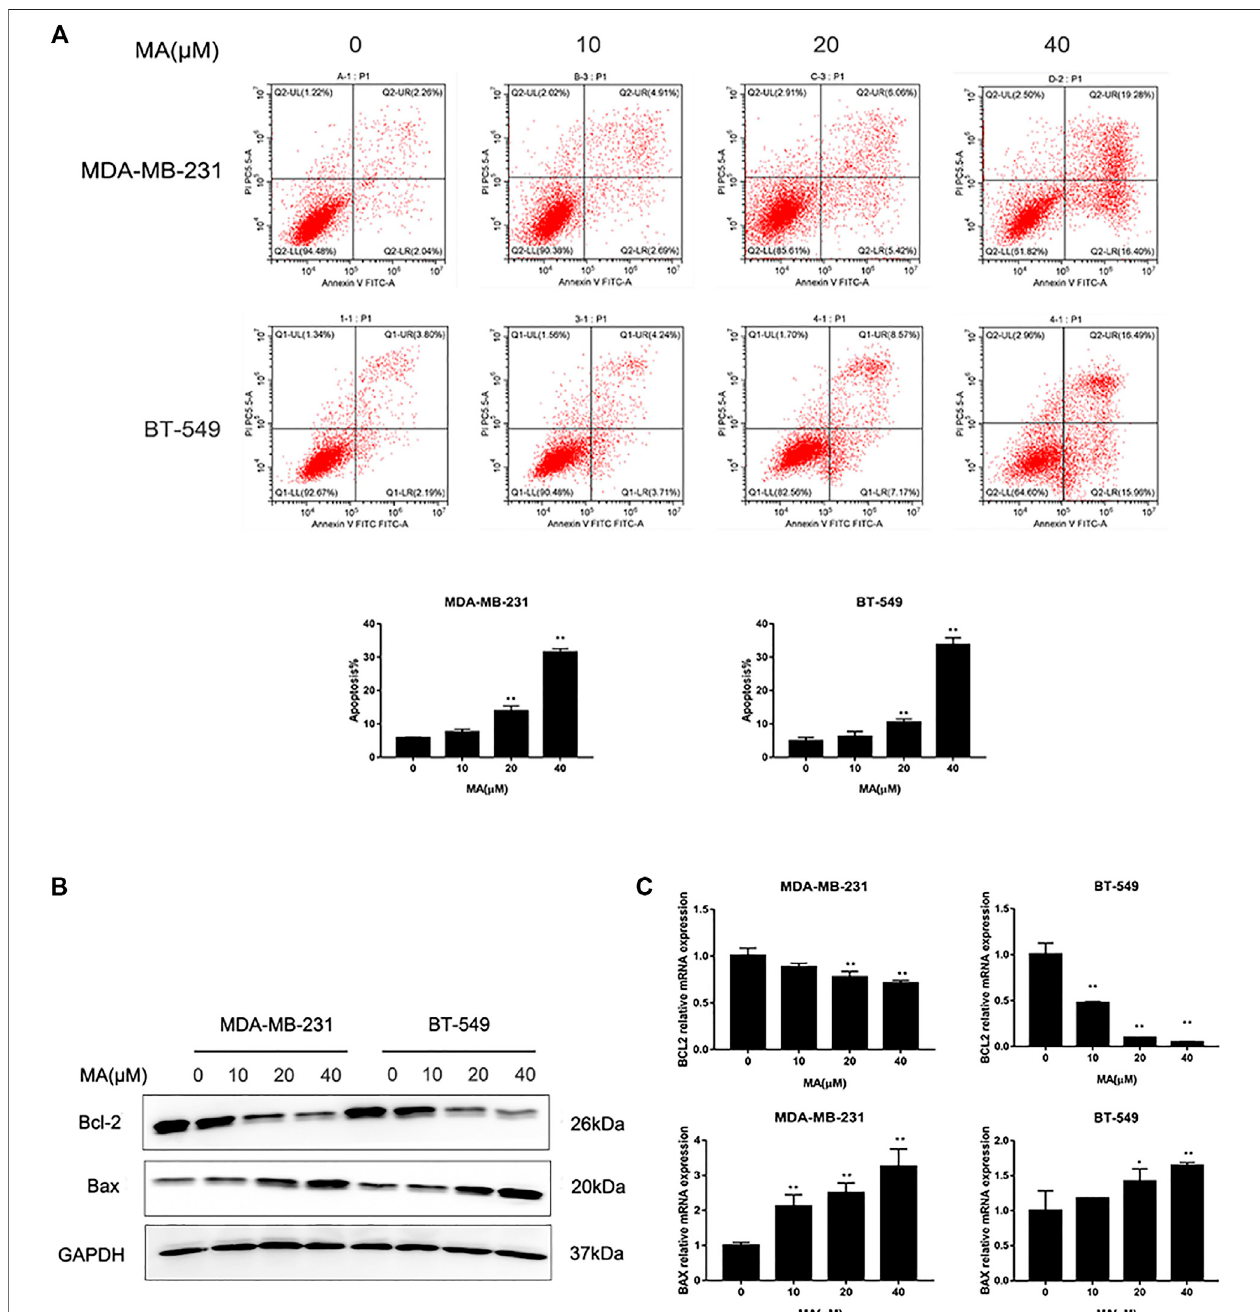
FIGURE3| MApromotesTNBCcellapoptosis. (A) Representativeimagesof fl owcytometryandpercentagesofapoptoticcellsinTNBCcellsdeterminedafterMA treatment for 24 h. (B) Western blot analysis of Bax and Bcl-2 protein expression after 24 h MA treatment. (C) Real-time PCR analysis of BAX and BCL-2 mRNA expression after 24 h MA treatment. Compared with the control group (0 μ M), ** p < 0.01.